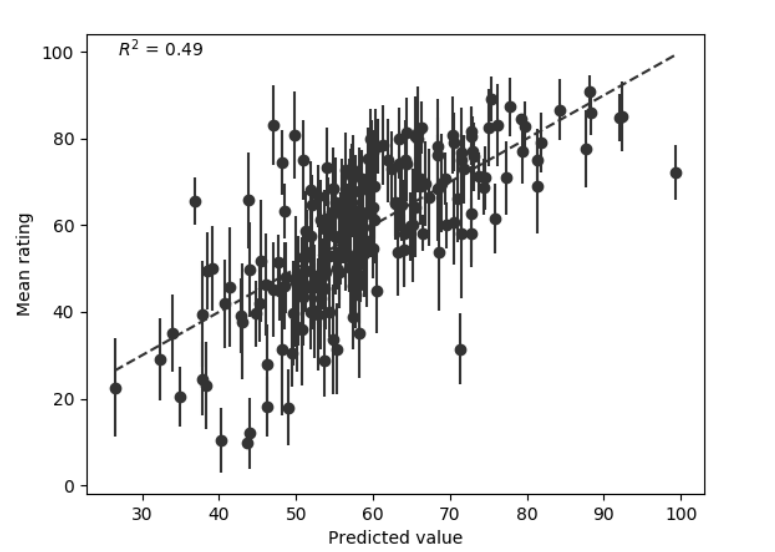
Figure 7. Performance of a linear regression model based only on the features proposed by Freed